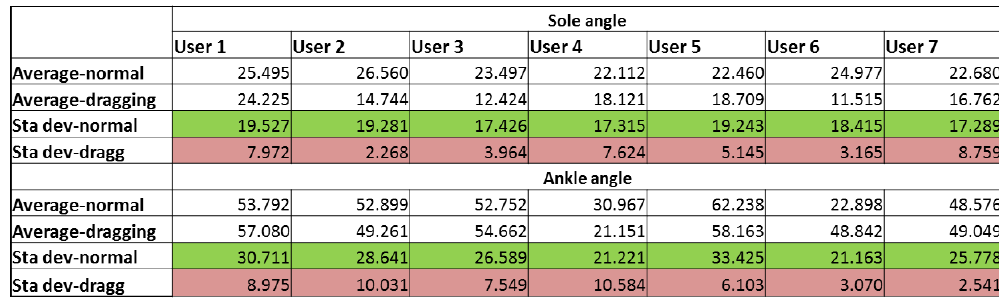
Table 2. Average and standard deviation of the angles.